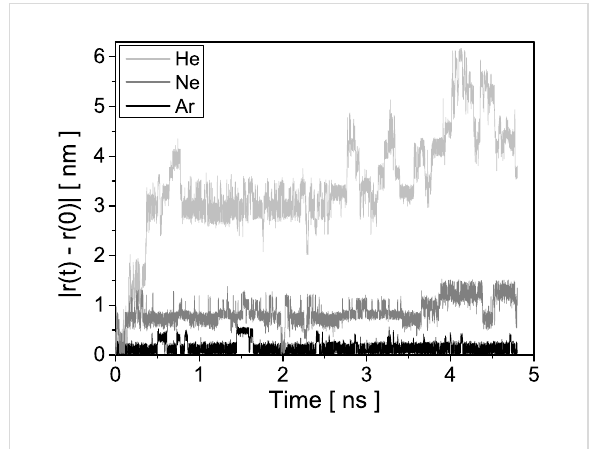
Figure 3: Displacement of He, Ne and Ar from their initial positions in HD-PMMA sample at 300 K. No periodic boundary conditions were used to extract atoms positions from trajectory file, that is why the maximum displacement for He atom extends above the system size. The trajectories have been selected to reflect the average mobility of the rare gas species in